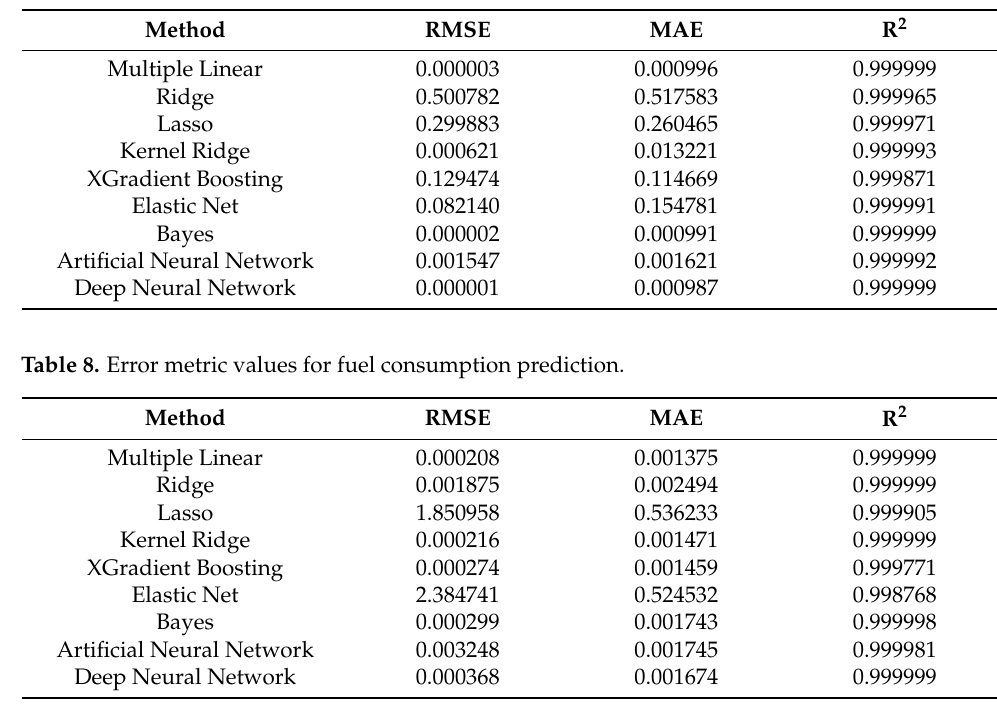
Table 7. Error metric values for power prediction.